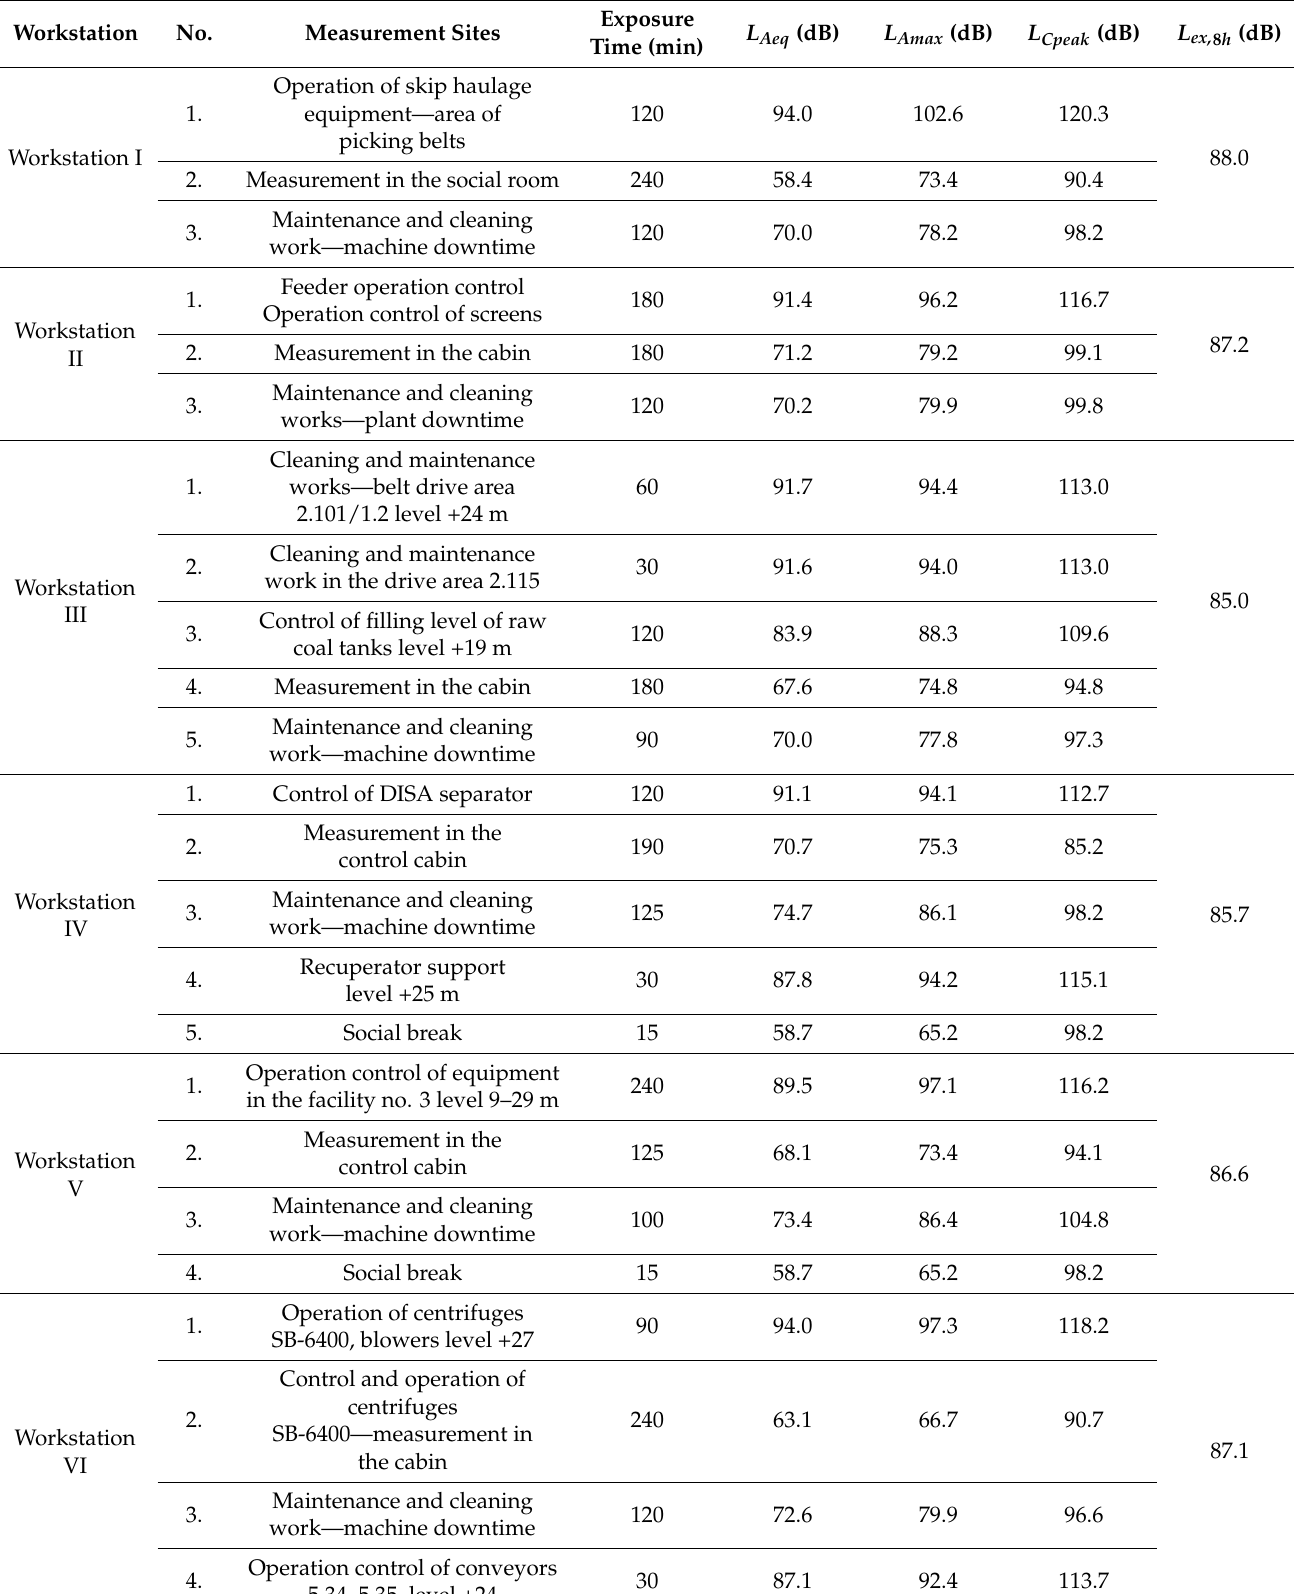
Table 2. Results of noise measurements at six workstations in the mechanical coal processing plant. Workstation No. Measurement